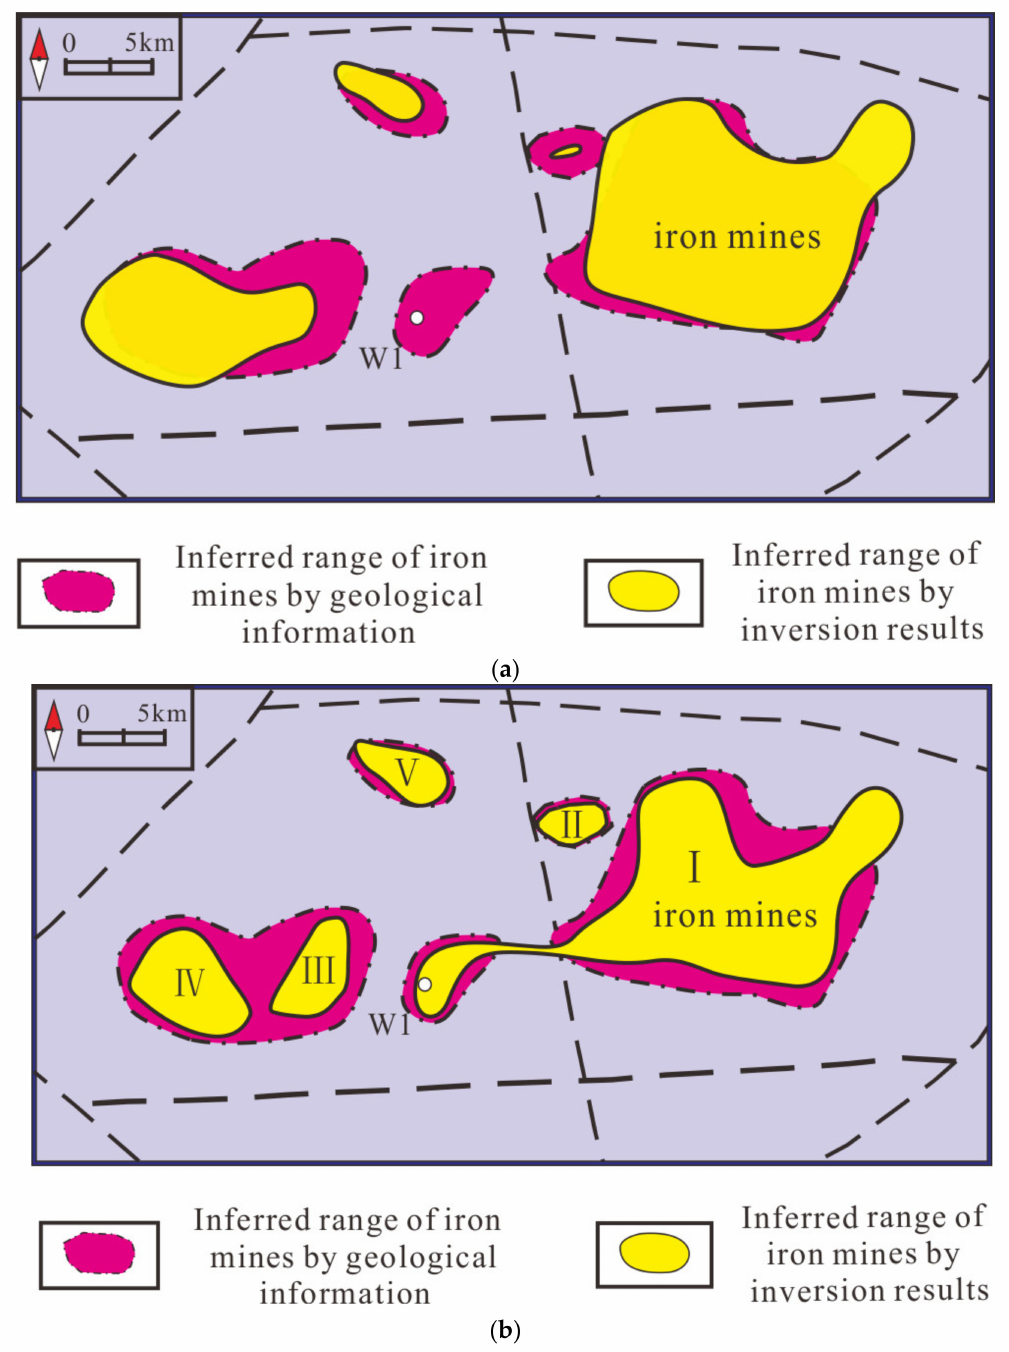
Figure 14. Distribution of density inversion results. ( a ) The modified location of iron mines by data combined joint inversion method. ( b ) The modified location of iron mines by the proposed cooperative density inversion